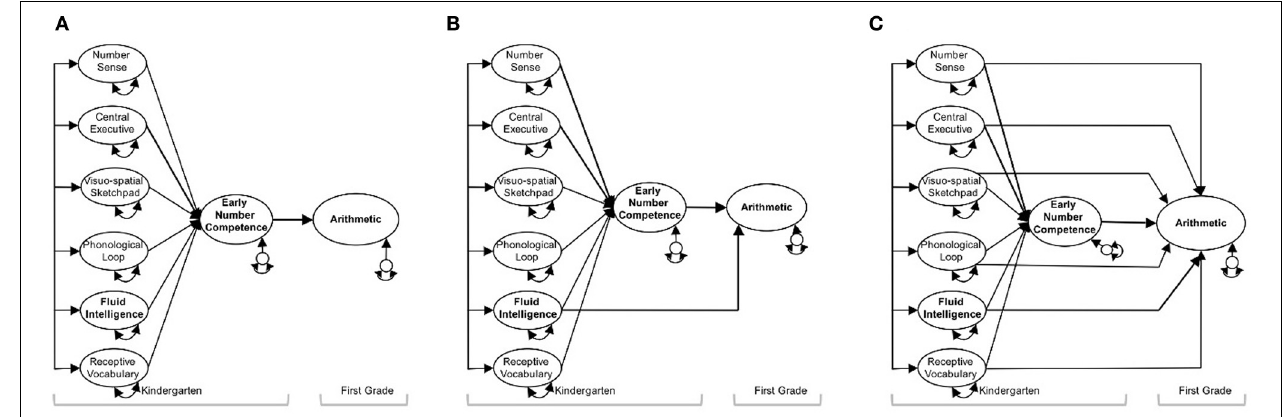
FIGURE 1 | Illustration for mediation analyses. Three mediation models to study how cognitive predictors measured at kindergarten influence arithmetic in first grade via early number competence.